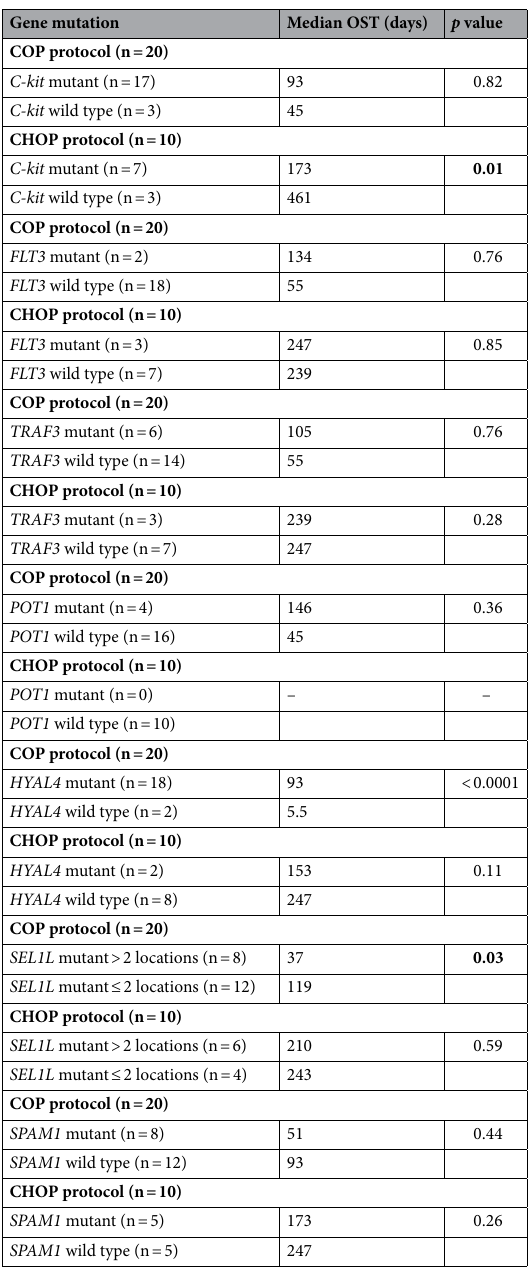
Table 3. Survival analysis of selected mutant and wild type genes in 30 diffuse large B-cell lymphomas treated with COP- and CHOP-based chemotherapy. Significant values are in